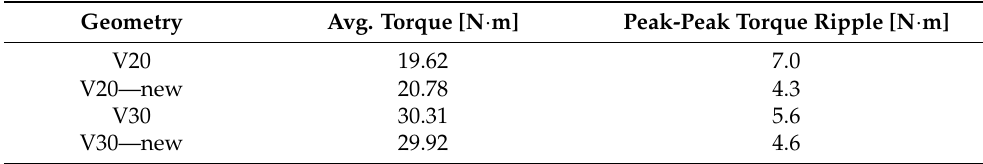
Table 5. Average torque and torque ripple.